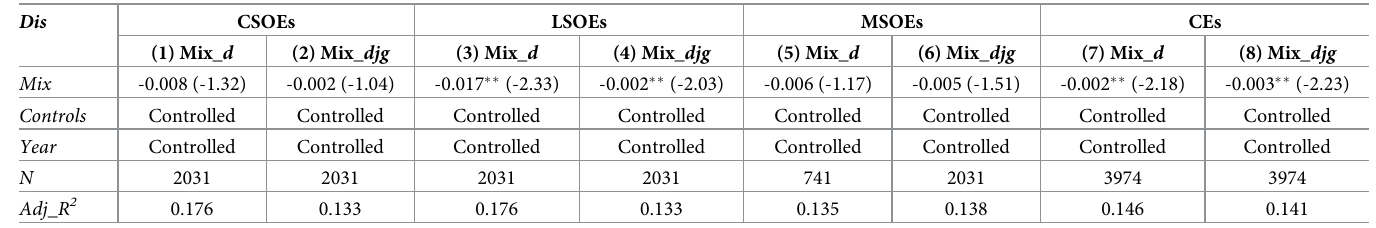
Table 8. The role of industry competition